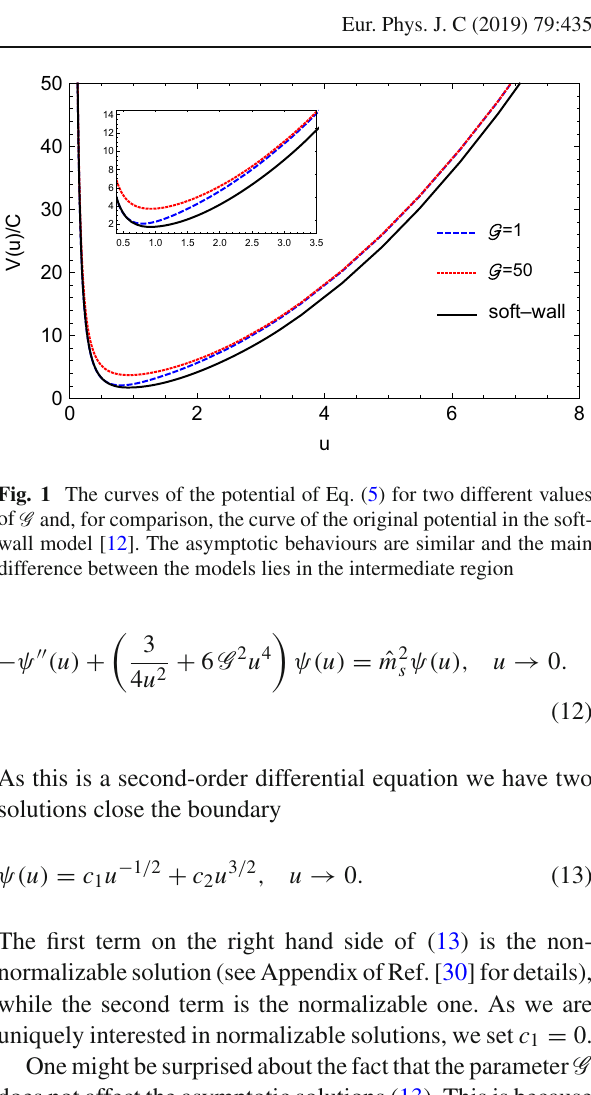
− ψ (cid:5)(cid:5) ( u )